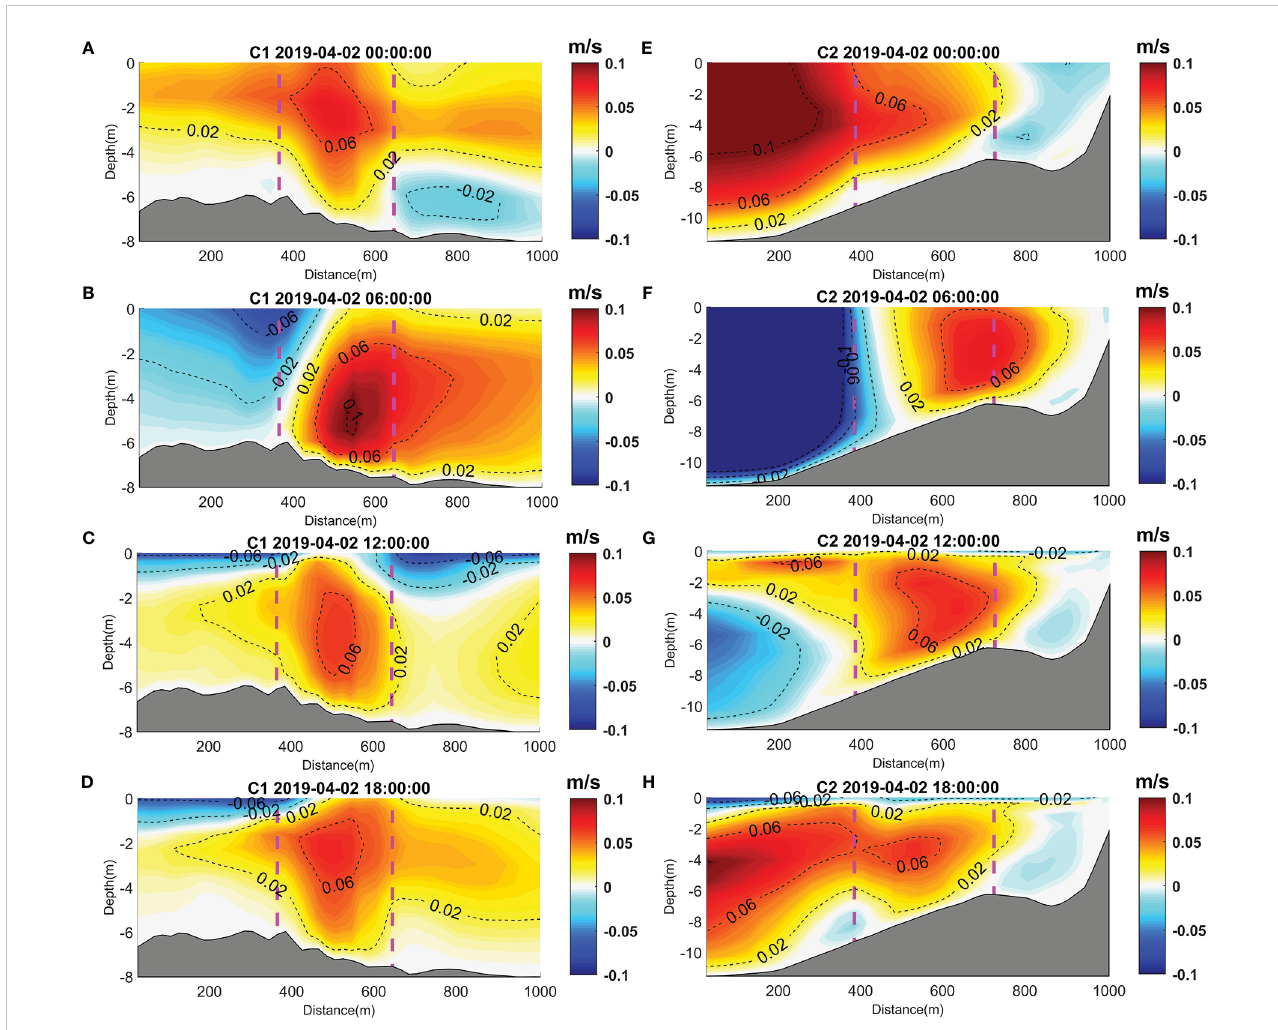
FIGURE 8 Velocity pro fi les with 6-hour intervals of the two model cases: (A – D) C1, with an offshore inlet mouth, and (E – H) C2, with a downstream inlet mouth. Colored shading represents the horizontal velocity magnitude perpendicular to the section, with a positive value (red) representing in fl ow and a negative value (blue) representing out fl ow near the inlet. The gray patch is the section topography, whereas the two magenta vertical lines correspond to the two magenta dots in Figure 7, which mark the section fragment closest to the inlet